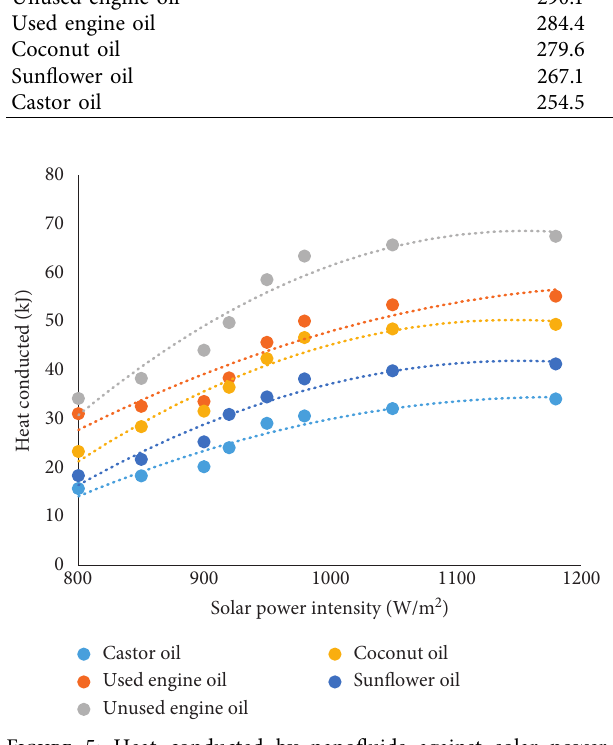
Figure 5: Heat conducted by nanofluids against solar power intensity.